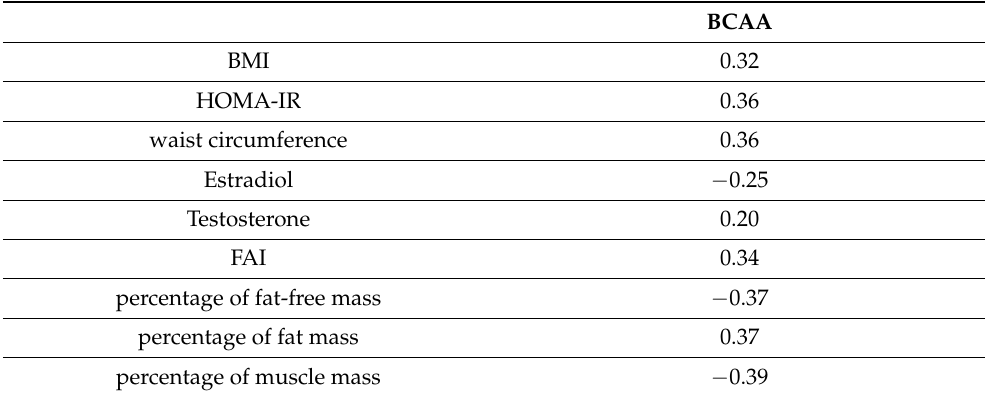
Table 3. Correlation of BCAA level with selected parameters.